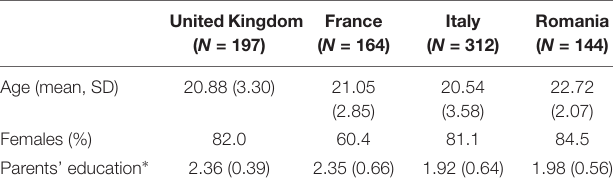
TABLE 2 | Demographic characteristics of the